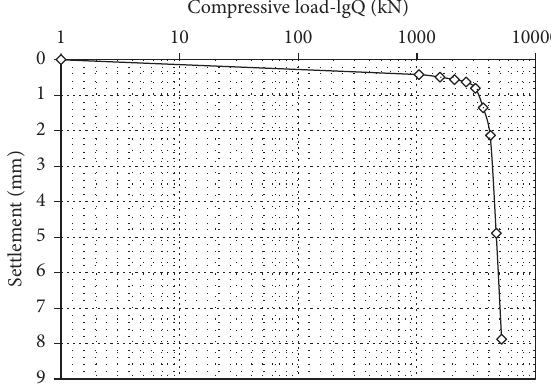
Figure 11: Q-s curves of the tested piles.